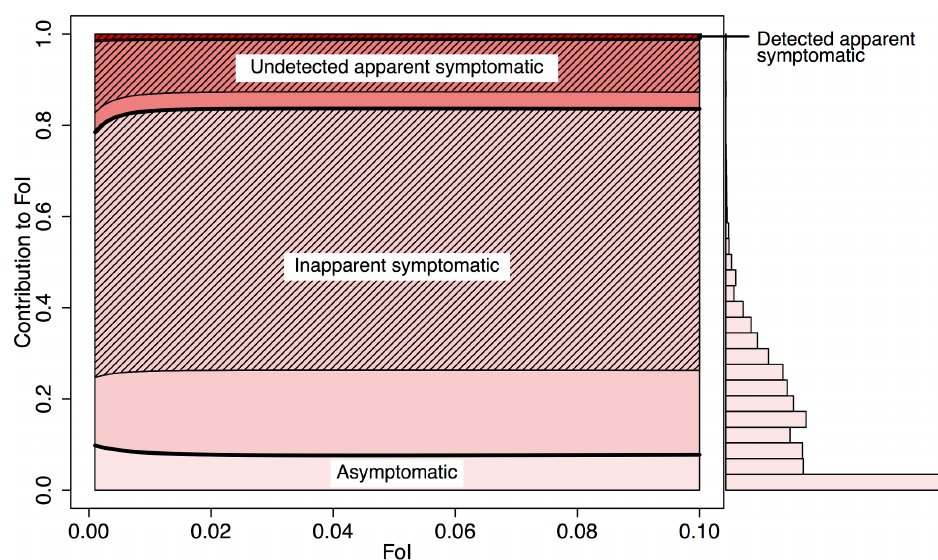
Fig 5. Mean contribution of each infection class to total force of infection (FoI). The contribution to the total FoI of an infection class is derived from the ratio of FoI attributable to a given class and total FoI, as in Eq (1). The respective net infectiousness is derived from the 3,000 random samples displayed in Fig 3. The infections are further distributed according to the estimated proportion of net infectiousness to occur before and after symptom onset (pre- symptomatic (Eq (5)) and post-symptomatic (hatched lines) (Eq (6)). The histogram shows the distribution of FoI contributions by asymptomatic infections at FoI = 0.1, accounting for parameter